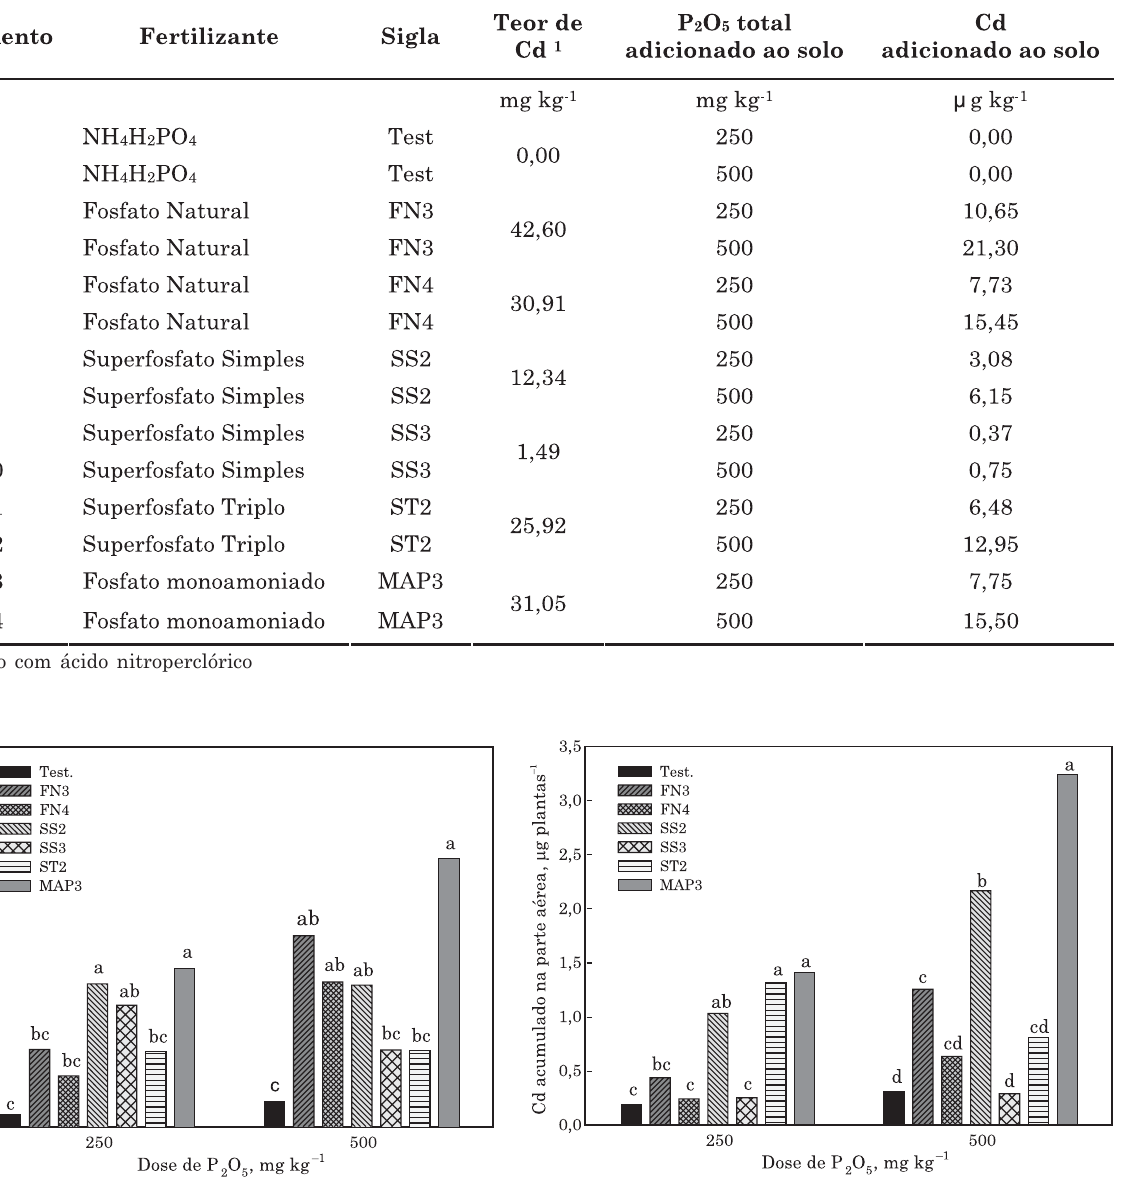
Figura 1. Quantidade de Cd acumulado nas raízes da aveia preta pela adição de fertilizantes fosfatados a um Nitossolo Vermelho distroférrico latossólico. Médias seguidas por mesma letra na dose não diferem pelo teste de Tukey a 5 %.